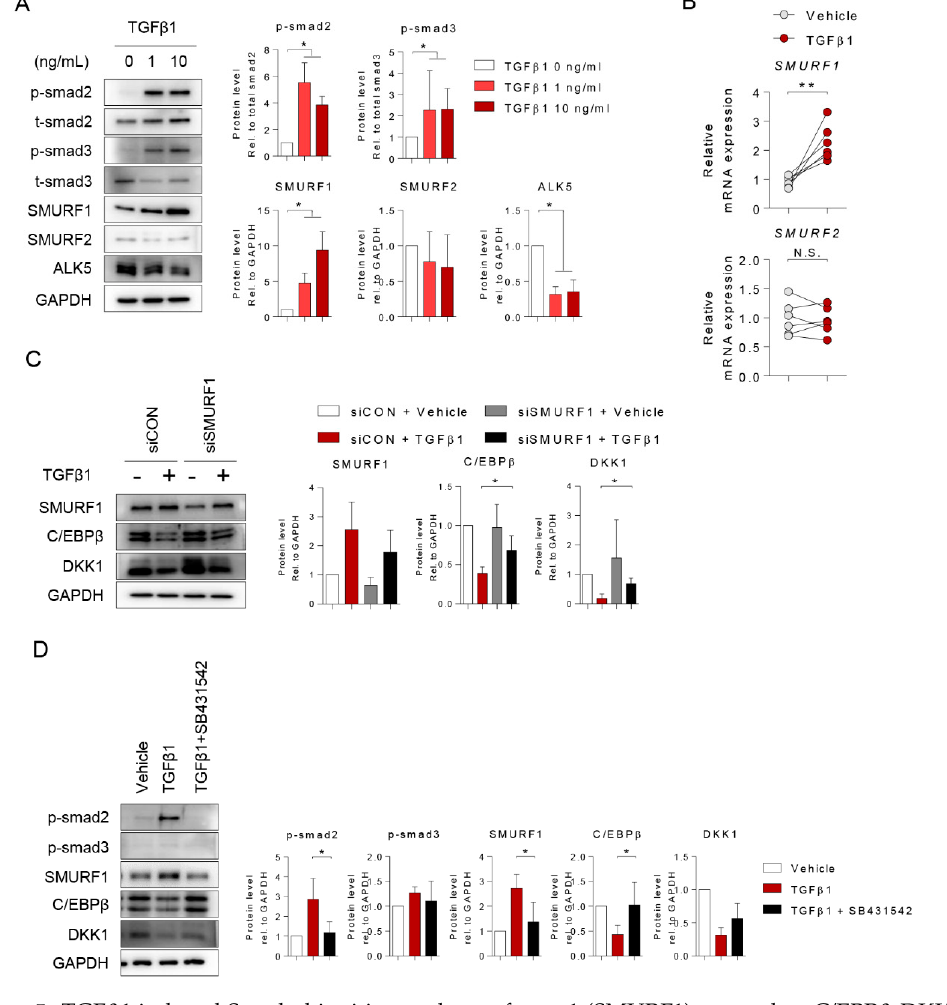
Figure 5. TGF β 1 induced Smad ubiquitin regulatory factor 1 (SMURF1) to regulate C / EBP β